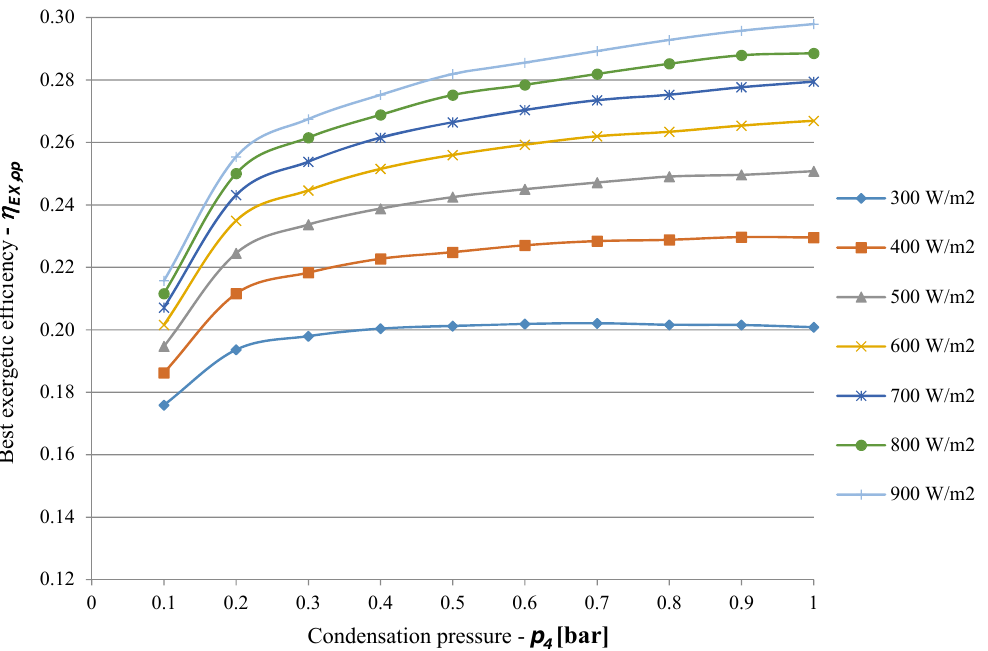
Figure 13. Optimal exergetic efficiencies versus solar radiation and condensation pressure. Table 2. Optimal evaporation temperatures and exergetic efficiencies of the PTC ‐ SRC system when condensation pressure is fixed at 1 bar.